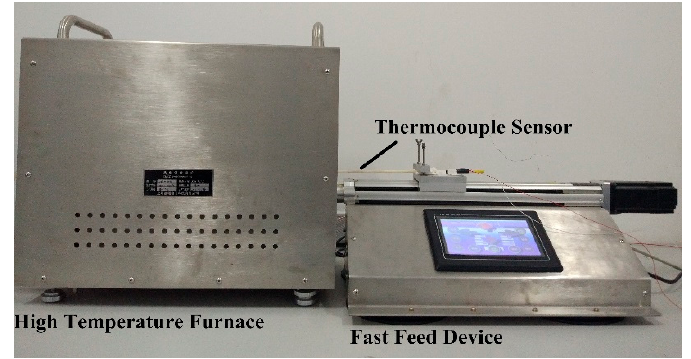
Figure 3. Experimental setup.